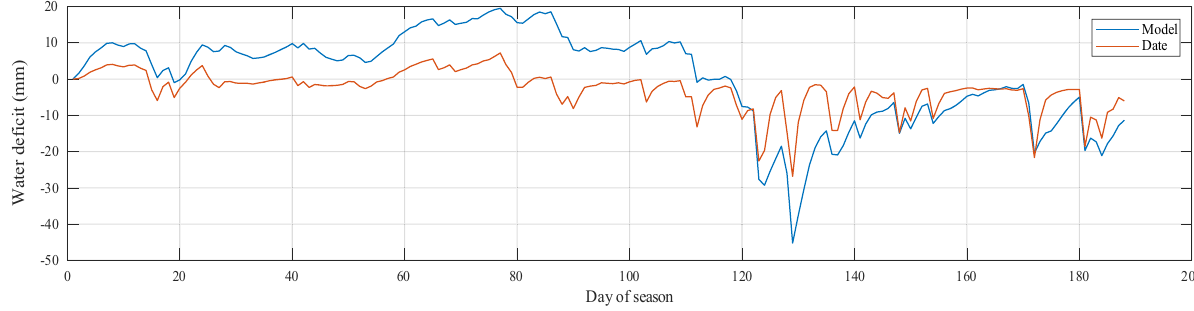
Figure 5: Model fi t and data for data from the Year 1989.